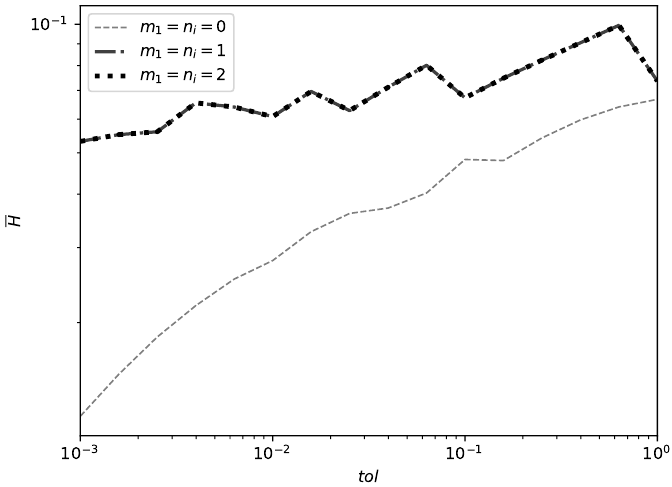
Figure 10. The diagrams show the average step sizes of the variable-step Jacobi co-simulation method (Algorithm 1, (39) and (50), H 1 = 10 − 4 ), different orders of interpolation polynomials and different internal subsystem